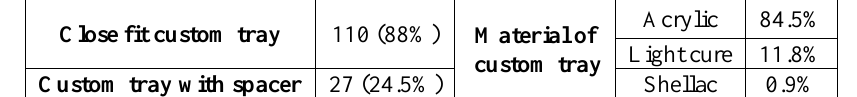
Table 5: Types and materials of custom tray used to register final impression for